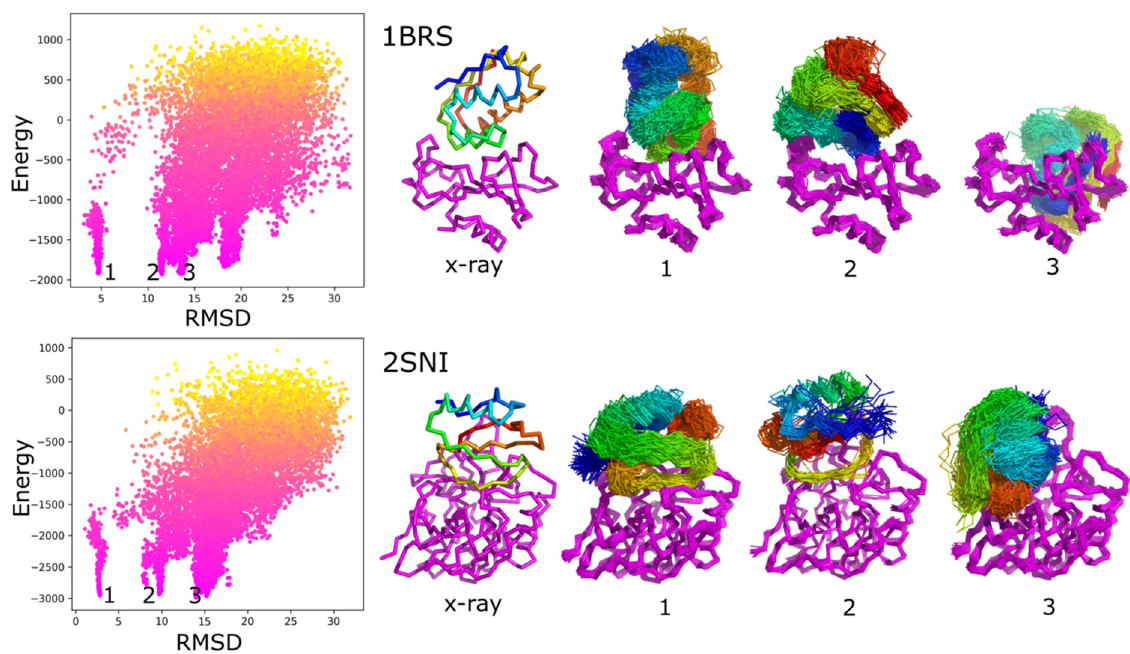
Figure 1. Characterization of docking results using RMSD to the X-ray structure and system energy. The left panels show the interface-RMSD versus CABS energy values. Point color represents the temperature—from yellow ( high ) to pink ( low ). The molecular visualizations show X-ray structures and ensembles of predicted models corresponding to selected energy minima (numbered in the picture from 1 to 3). As presented in the picture, the minima numbered as 1st corresponds to near-native protein–protein arrangements, others to non-native ensembles, as presented in the picture. The presented ensembles are the sets of similar models found in the structural clustering of contact maps (see Methods). The figure shows two modeling cases: 1BRS and